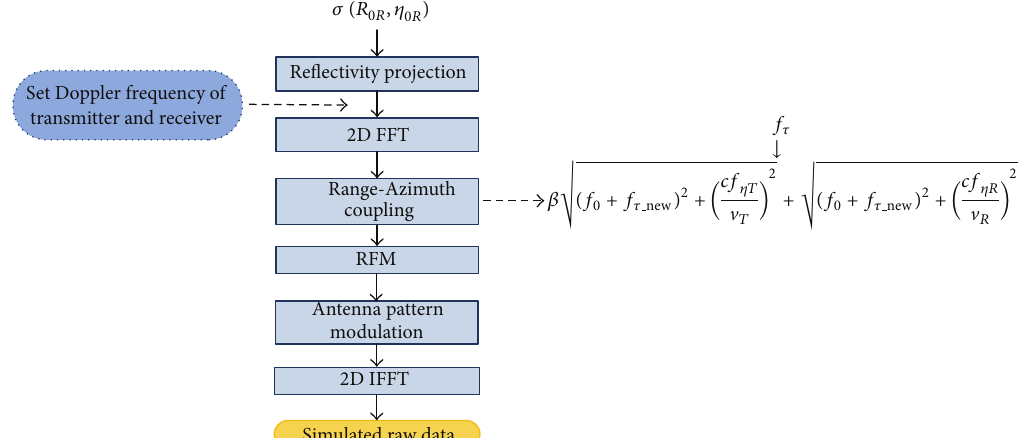
Figure 3: Flow of the proposed raw data simulator.